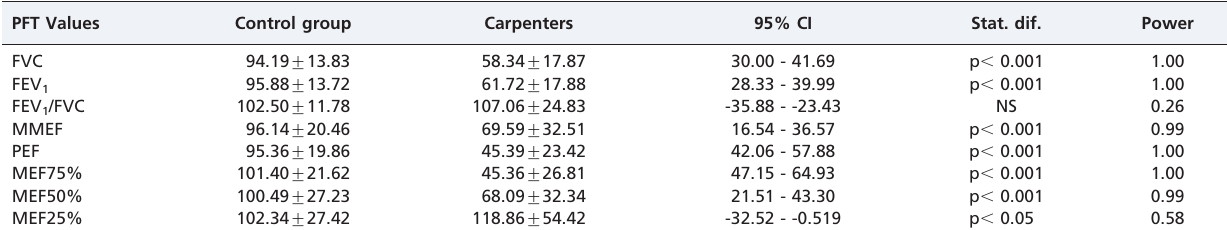
Table 4 - Comparison of pulmonary functional tests (PFT) between control group and carpenters. PFT Values Stat. dif.